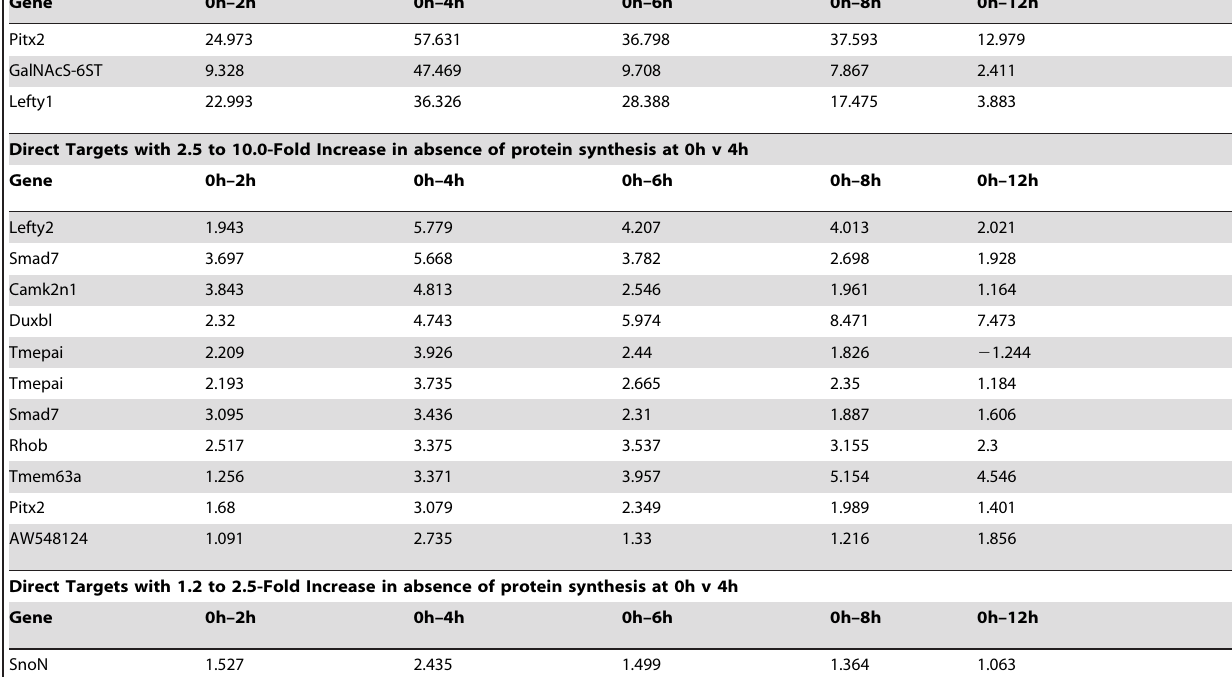
Direct Targets with $ 10.0-Fold Increase in absence of protein synthesis at